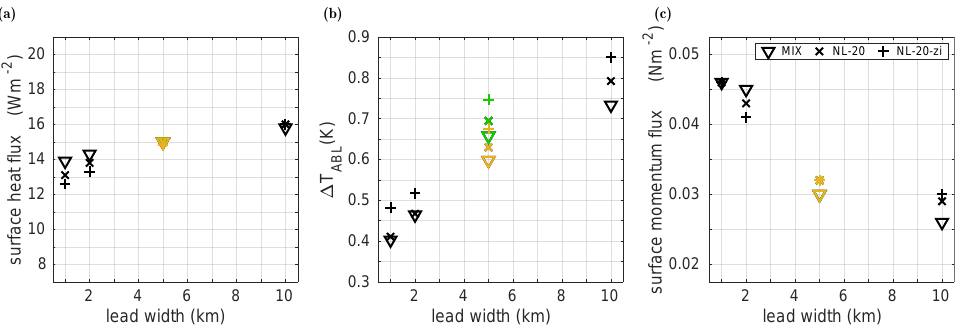
Figure 8. Domain-averaged values of three characteristic quantities against the lead width as obtained by all model runs for the five different lead-resolving cases. Results for the cases ENS-5km-d20km (green) and ENS-5km-d40km (yellow) are both plotted against 5km lead width. ( a ) shows the surface sensible heat flux; ( b ) the air temperature difference in the ABL with respect to the inflow region temperature; and ( c ) the surface momentum flux. The model runs are explained in Section 2 (see also Table